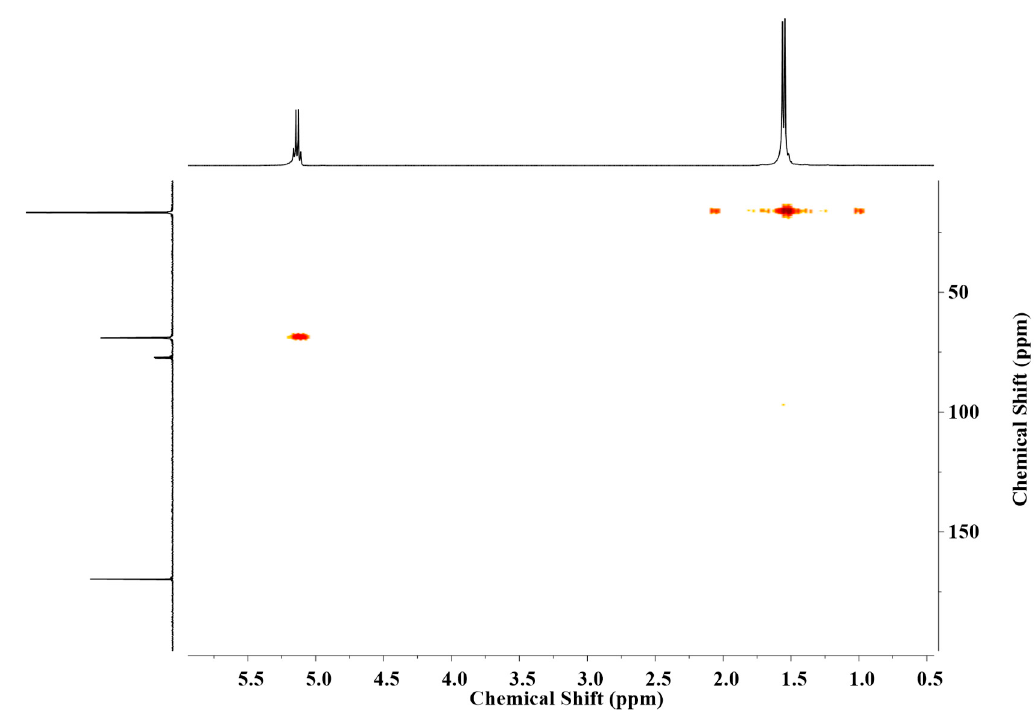
Figure 1. 1 H– 13 C NMR (HMQC) spectra for L , D -PLA.